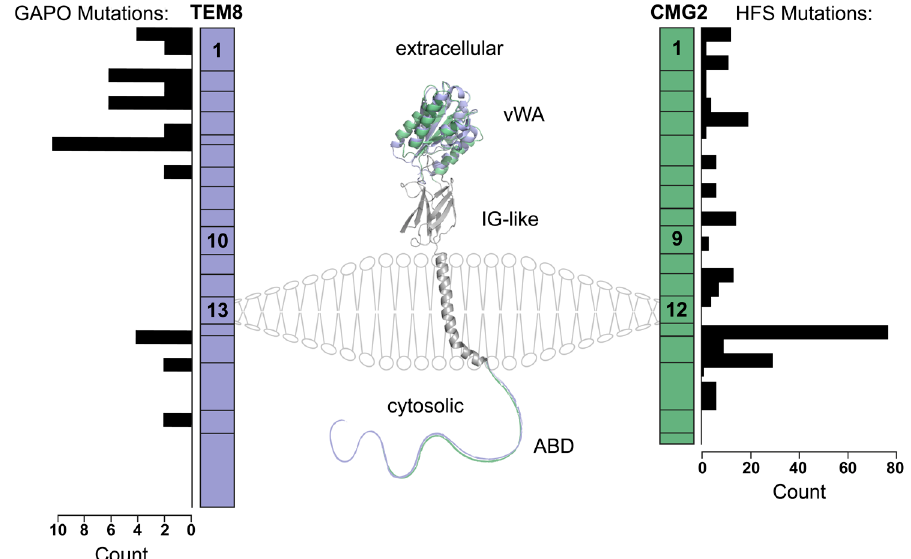
Figure 1. TEM8 and CMG2 are similar in gene and protein structure: mutations in the former lead to GAPO and those in the latter lead to HFS. Tumor endothelial marker 8 (TEM8) (blue) and capillary morphogenesis gene 2 (CMG2) (green) have similar exon schemes and protein structures. Crystal structures of the von Willebrand factor type A (vWA) domain of TEM8 (Protein Data Bank [PDB]: 3N2N 8 ) and CMG2 (PDB: 1TZN 9 ) are shown aligned. The immunoglobulin (Ig)-like and transmembrane domains have been modelled on CMG2 and are shown in gray 10 . The cytosolic tails, longer for TEM8 than for CMG2, are intrinsically disordered with a conserved juxtamembranous actin- binding domain (ABD). The number of reported occurrences of mutations in growth retardation, alopecia, pseudo-anodontia, and optic atrophy (GAPO) is depicted next to TEM8, and the corresponding number in hyaline fibromatosis syndrome (HFS) is shown next to CMG2. The number of HFS patients with mutations in CMG2 is almost an order of magnitude higher than those of